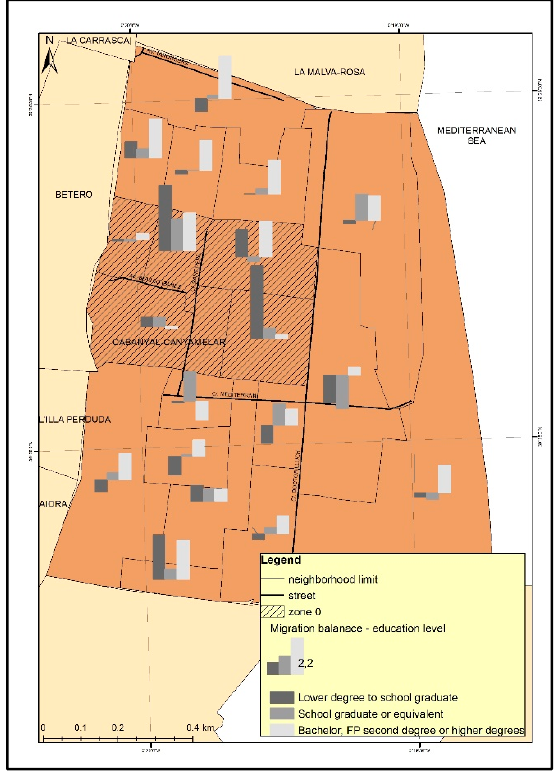
Figure 10. Migration balance in Cabanyal and zone 0 based on education level, 2014–2016.